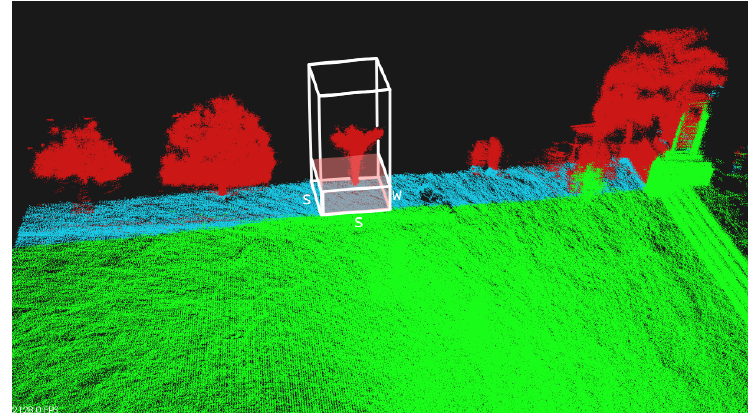
Figure 13. Segmentation Process. Green: points to be segmented— M . White-box: sector under analysis— S . Pink-box: candidate ground points— W . Blue: points already segmented as ground— G . Red: points already classified as